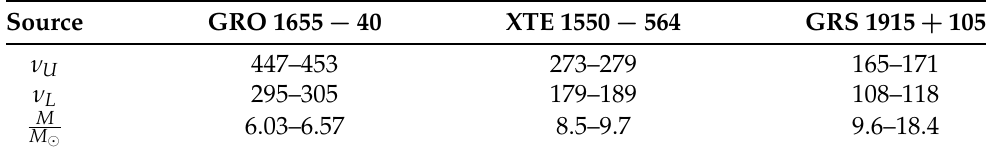
Figure 12. Representation of the upper oscillation frequency ν U at the resonance radius for different ratios related to Figure 11. We compared the frequency to the mass limits of microquasars obtained by observations. Their characteristics are given in Table 1. They are plotted for β = − 0.00001, β = 0 and β = 0.00001, and different values of α . The colors represent the same ratio as Figure 11. Table 1. Observed twin HF QPO data for the three microquasars, based on measurements indepen- dent of the HF QPO measurements given by the spectral continuum fitting